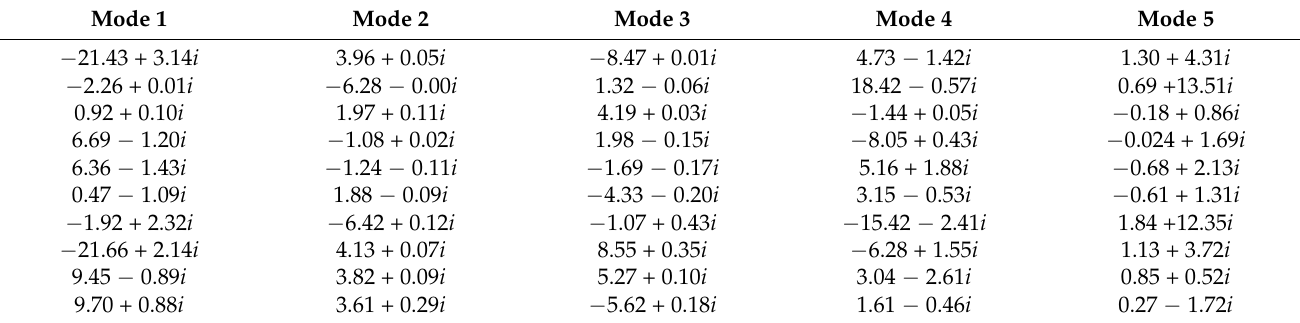
Table A4. Mode shape vector of UCBC #3 specimen. ( i : imaginary